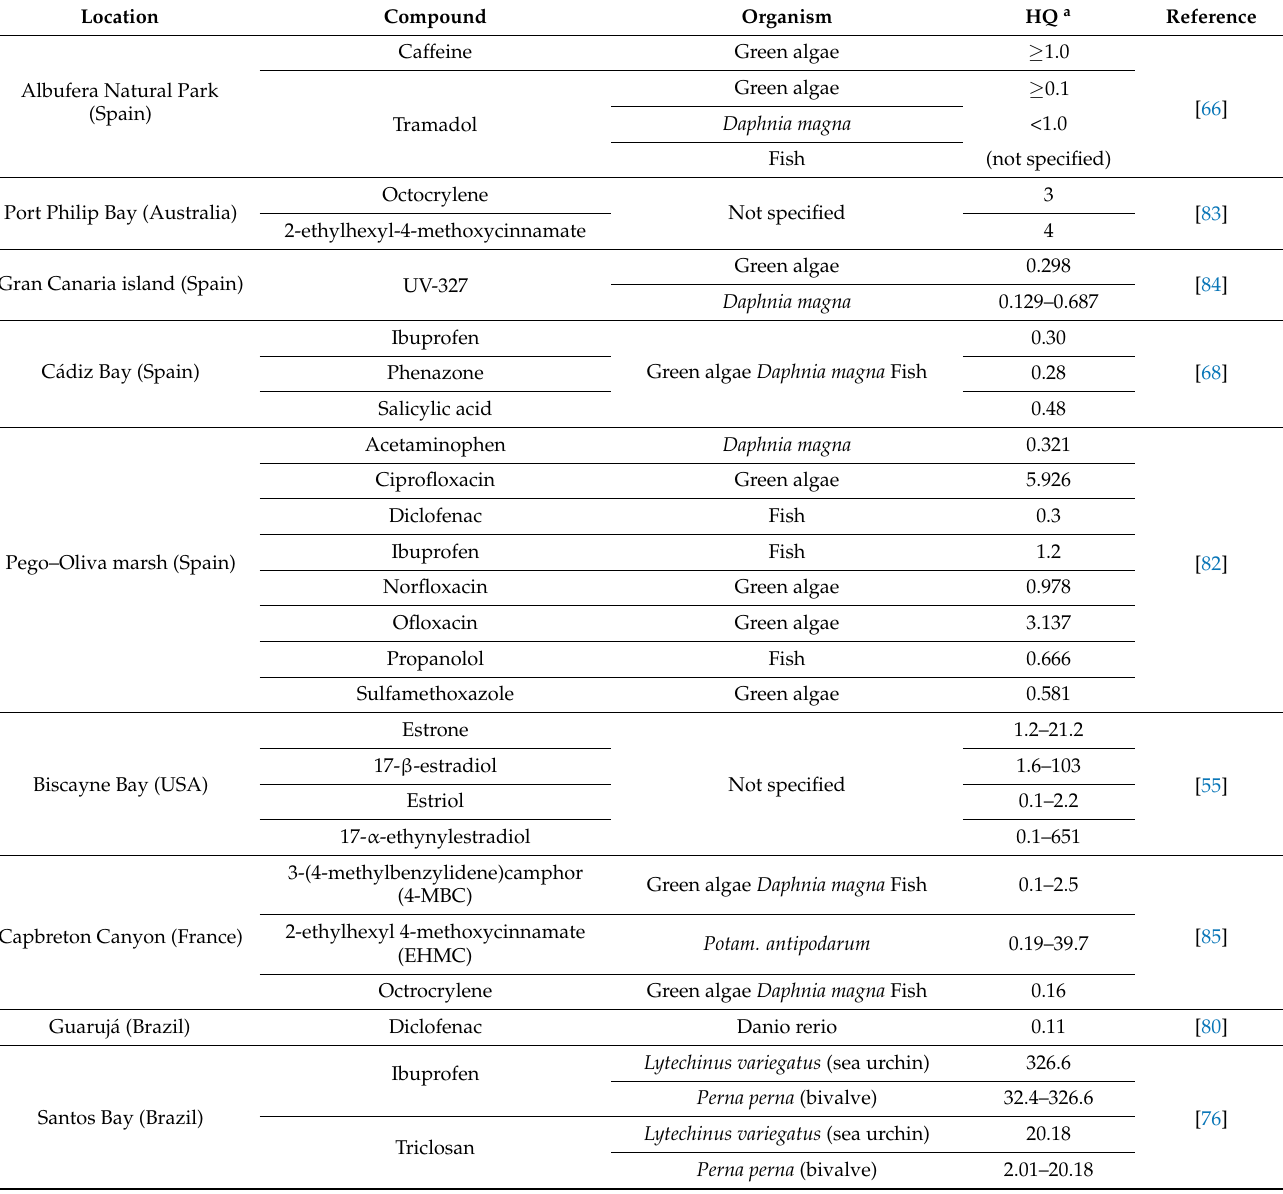
Table 3. Intermediate risk (0.1 ≤ HQ <1.0) or high environmental risk (HQs ≥ 1.0) found for pharmaceuticals and personal care products in seafront